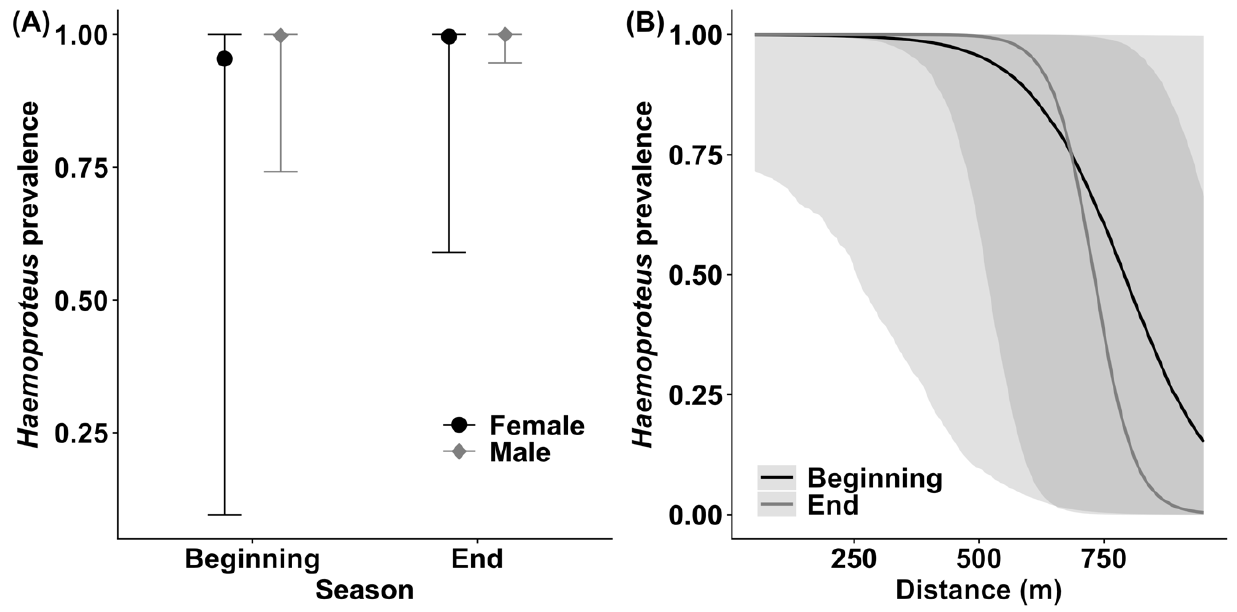
Figure 1. ( A ) Haemoproteus prevalence in the blood of male and female Pied Flycatchers at the beginning and the end of the breeding season. Error bars represent 95% credibility intervals. ( B ) The association between the distance from the nearest water bodies and Haemoproteus prevalence at the beginning and end of the breeding season. Solid lines show the estimated trendlines by the model, and grey-shaded areas represent 95% credibility intervals.